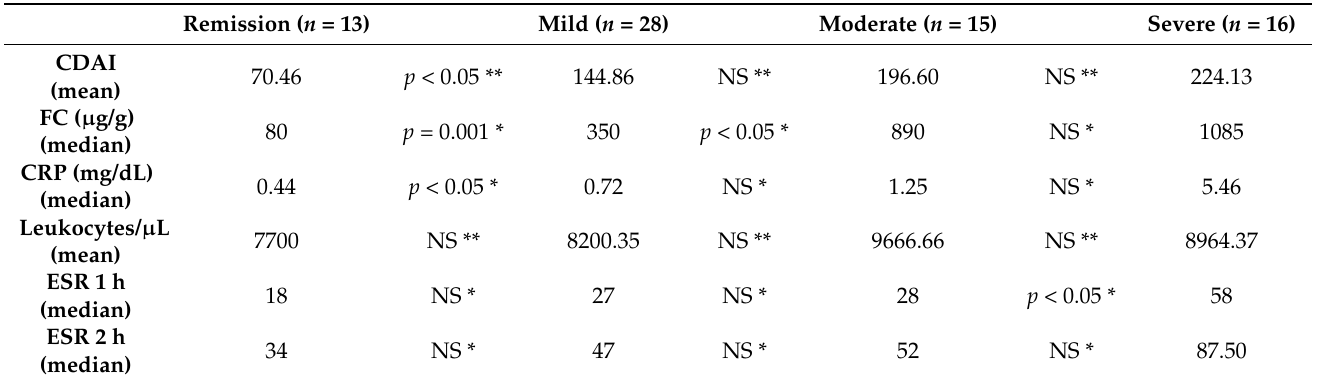
Table 3. Description of non-invasive parameters, according to the degree of endoscopic activity, in patients with Crohn’s disease.